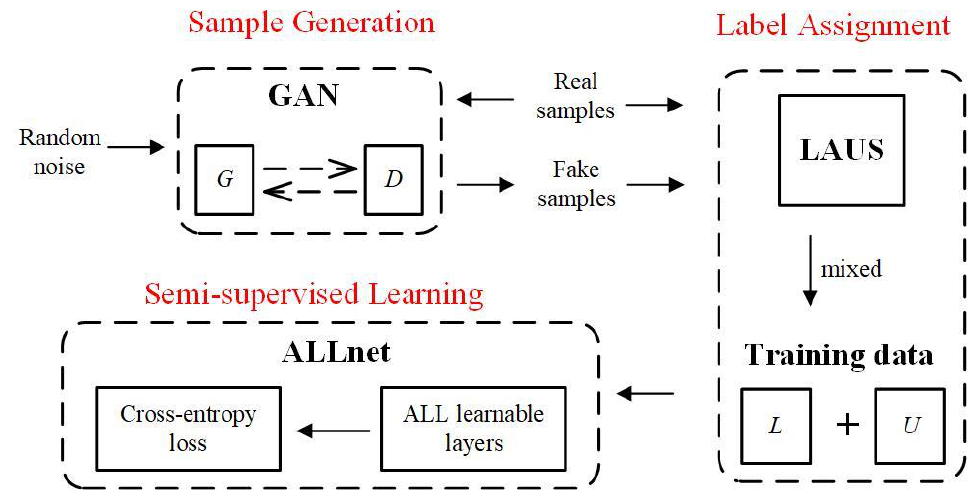
Figure 2. The proposed SSL framework. “L” and “U” represent labeled samples and unlabeled samples.